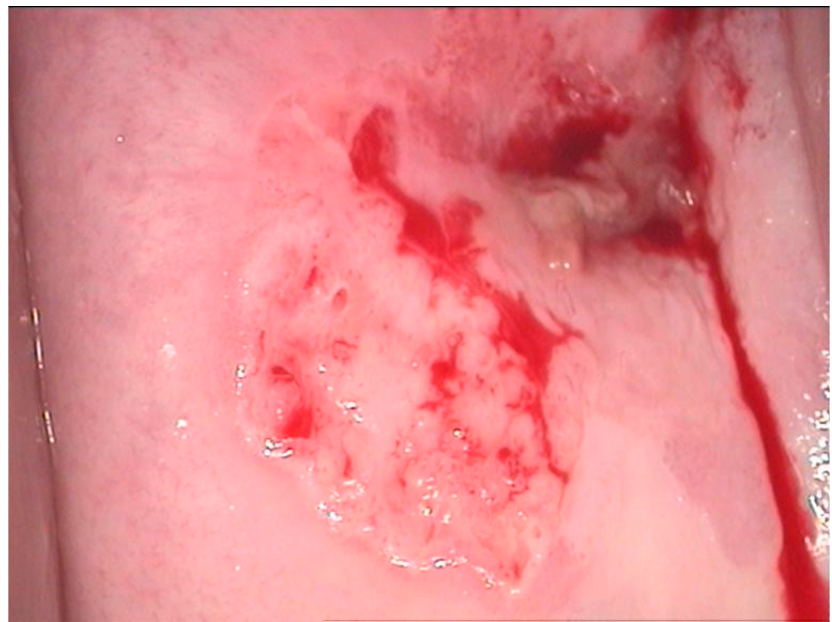
Figure 12. Colposcopic image of a HSIL cytology result depicting aceto-white epithelium at 7 o’clock with abnormal irregular and petechial vascularization that is highly suggestive of an invasive lesion.